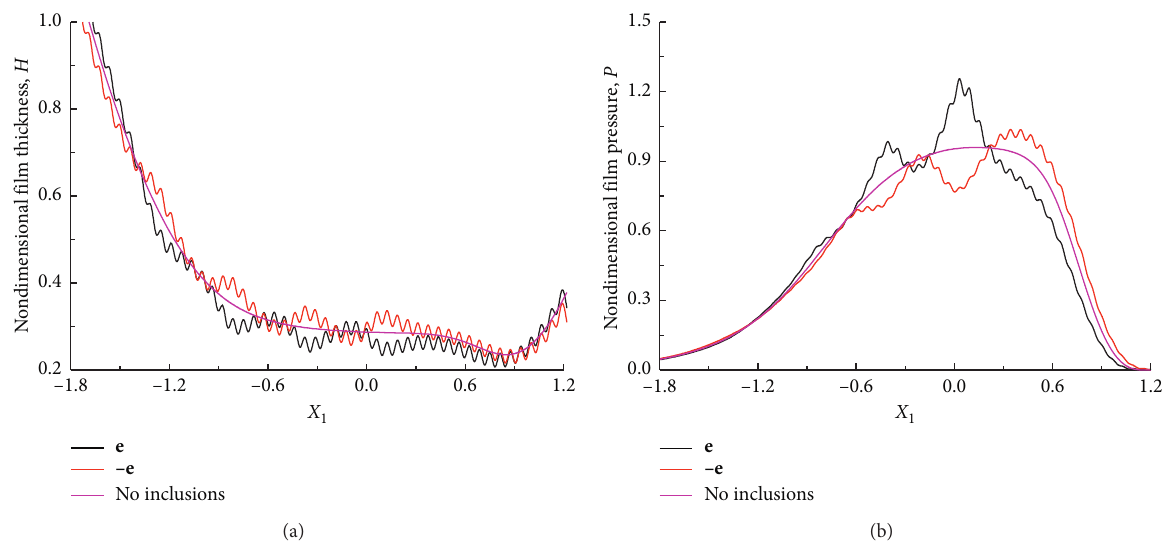
Figure 4: Nondimensional film thickness and pressure of the sinusoidal rough surface with the particle eigenstrains, e and − e